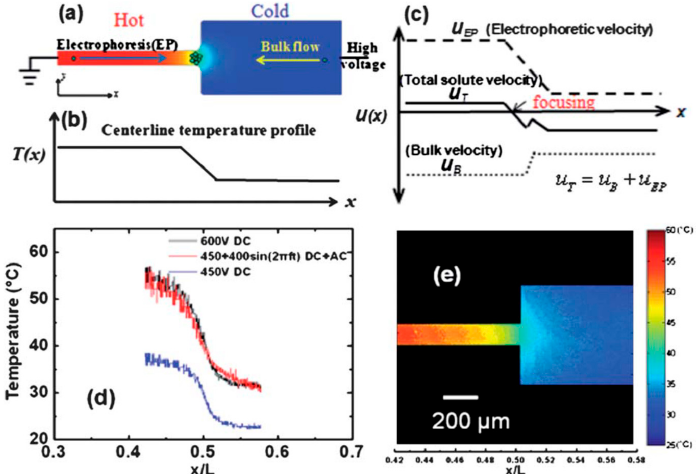
Figure 6. Principle of Joule heating induced TGF in a microfluidic sudden expansion under a combined AC/DC electric field. ( a ) Joule heating in the microfluidic expansion produces a temperature gradient around the junction region connecting narrow and wide channels; ( b ) temperature distribution along the centerline of microchannel (axial direction); ( c ) velocity profiles of sample solute along the centerline of microchannel due to pure electrophoresis (dashed line), pure bulk flow (dotted line), a combination of electrophoresis and bulk flow (solid line); ( d ) temperature distributions along the centerline of a 10 mm long polydimethylsiloxane (PDMS) microchannel for three different applied voltages: 450 V DC, 450 V DC + 400 sin(2 π ft ) V AC and 600 V DC, measured with the rhodamine B thermometry; ( e ) temperature contour in the microfluidic expansion for an applied voltage of 450 V DC + 400 sin(2 pft ) V AC, measured in 180 mM Tris–borate buffer solution. Reprint from Ref. [82].